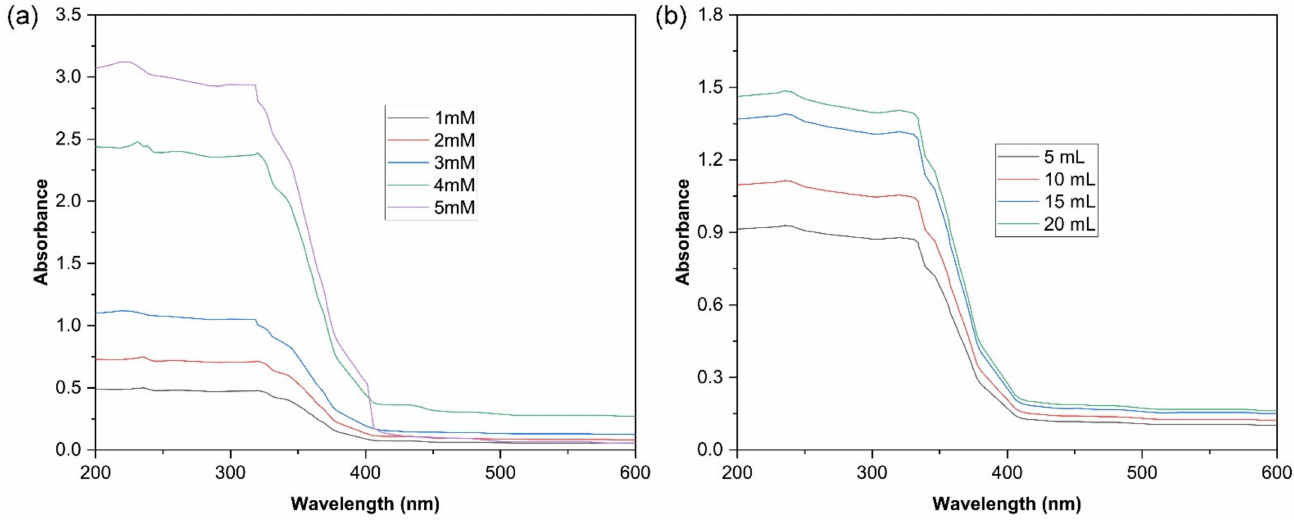
Figure 1. UV-vis spectroscopy revealing the spectrum of TiO 2 NPs prepared by green synthesis using Ocimum sanctum leaf extract ( a ) bulk TiO 2 (1–5 mM) and using ( b ) aqueous leaf extract (5 mL–20